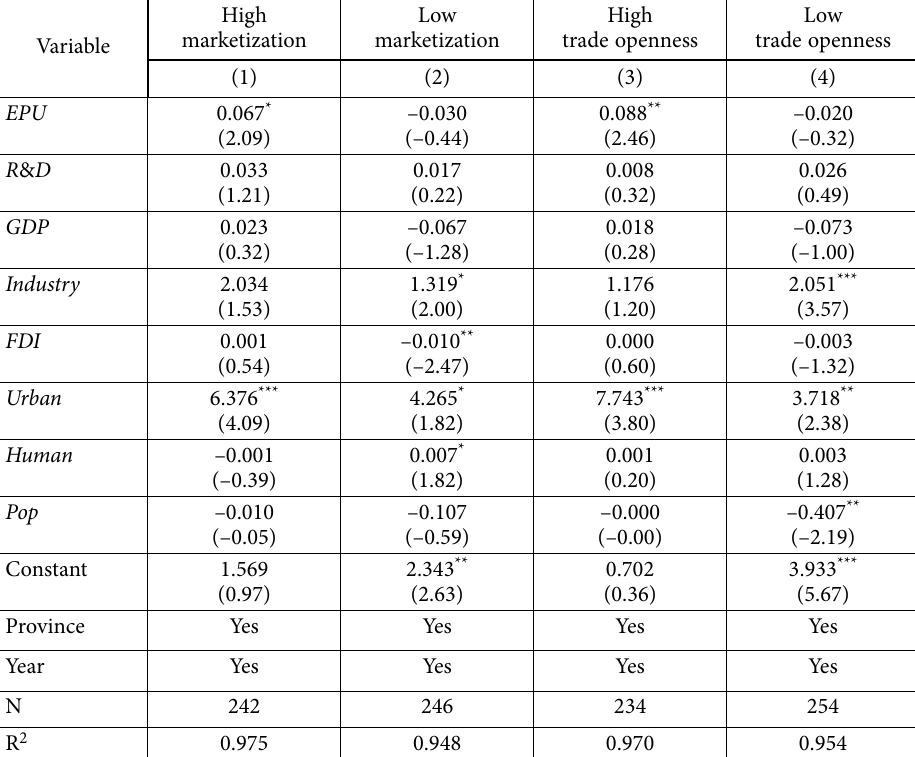
Table 5. Estimation results of different sub-samples